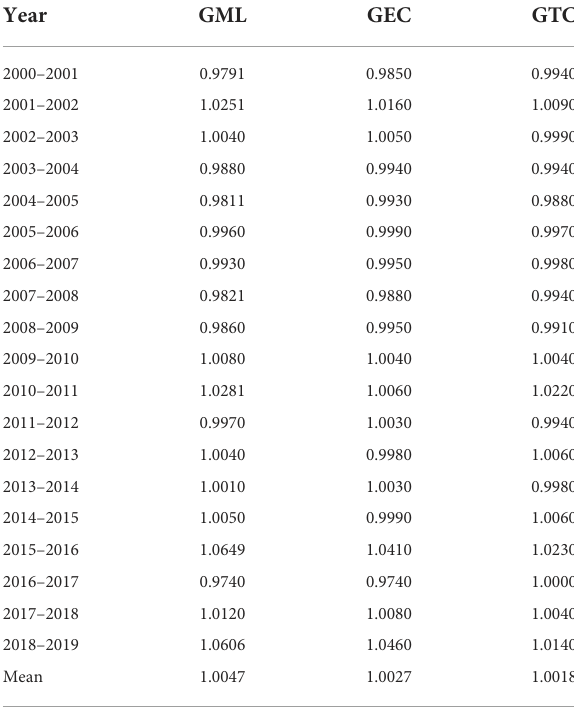
TABLE 3 Decomposition results of the GML index in China’s pharmaceutical industry.